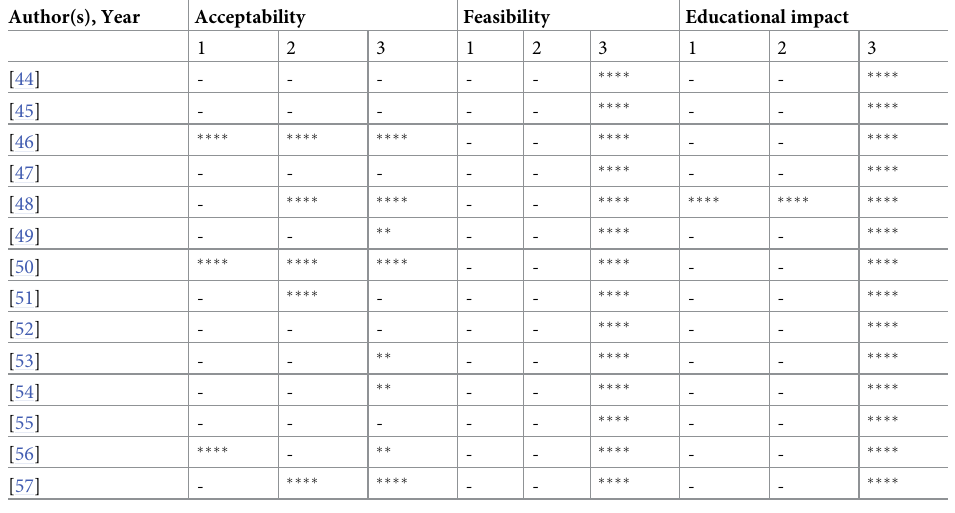
Table 8. Additional psychometric properties evaluated within each study adapted from Beattie et al.